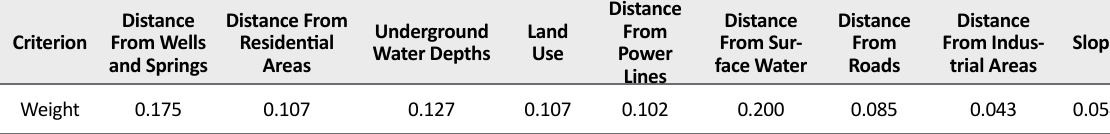
Table 2. Final weight of evaluation criteria site selection of